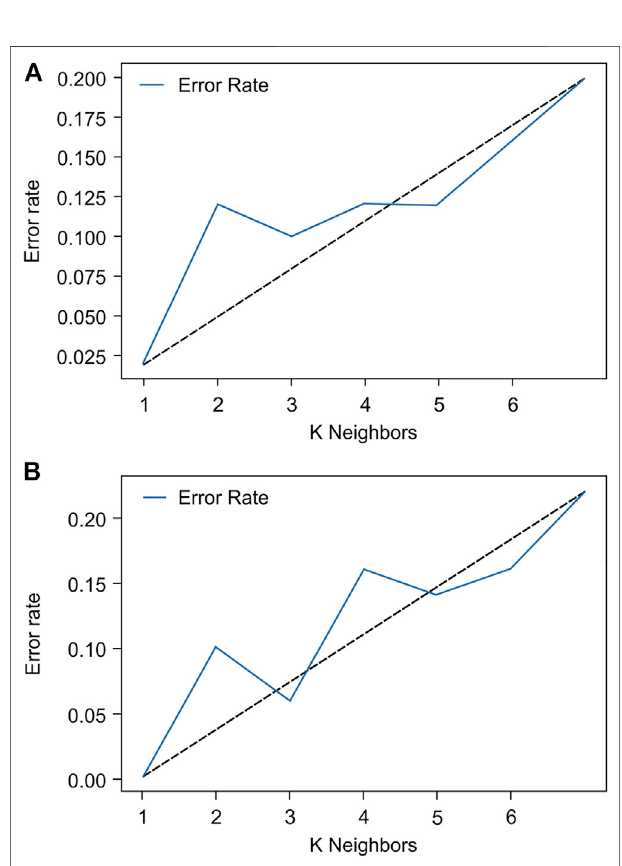
FIGURE 7 | The choice of K neighbors for the k-nearest neighbor with (A) the x-axis component of the three-dimensional acceleration signals and (B) the root sum of squares